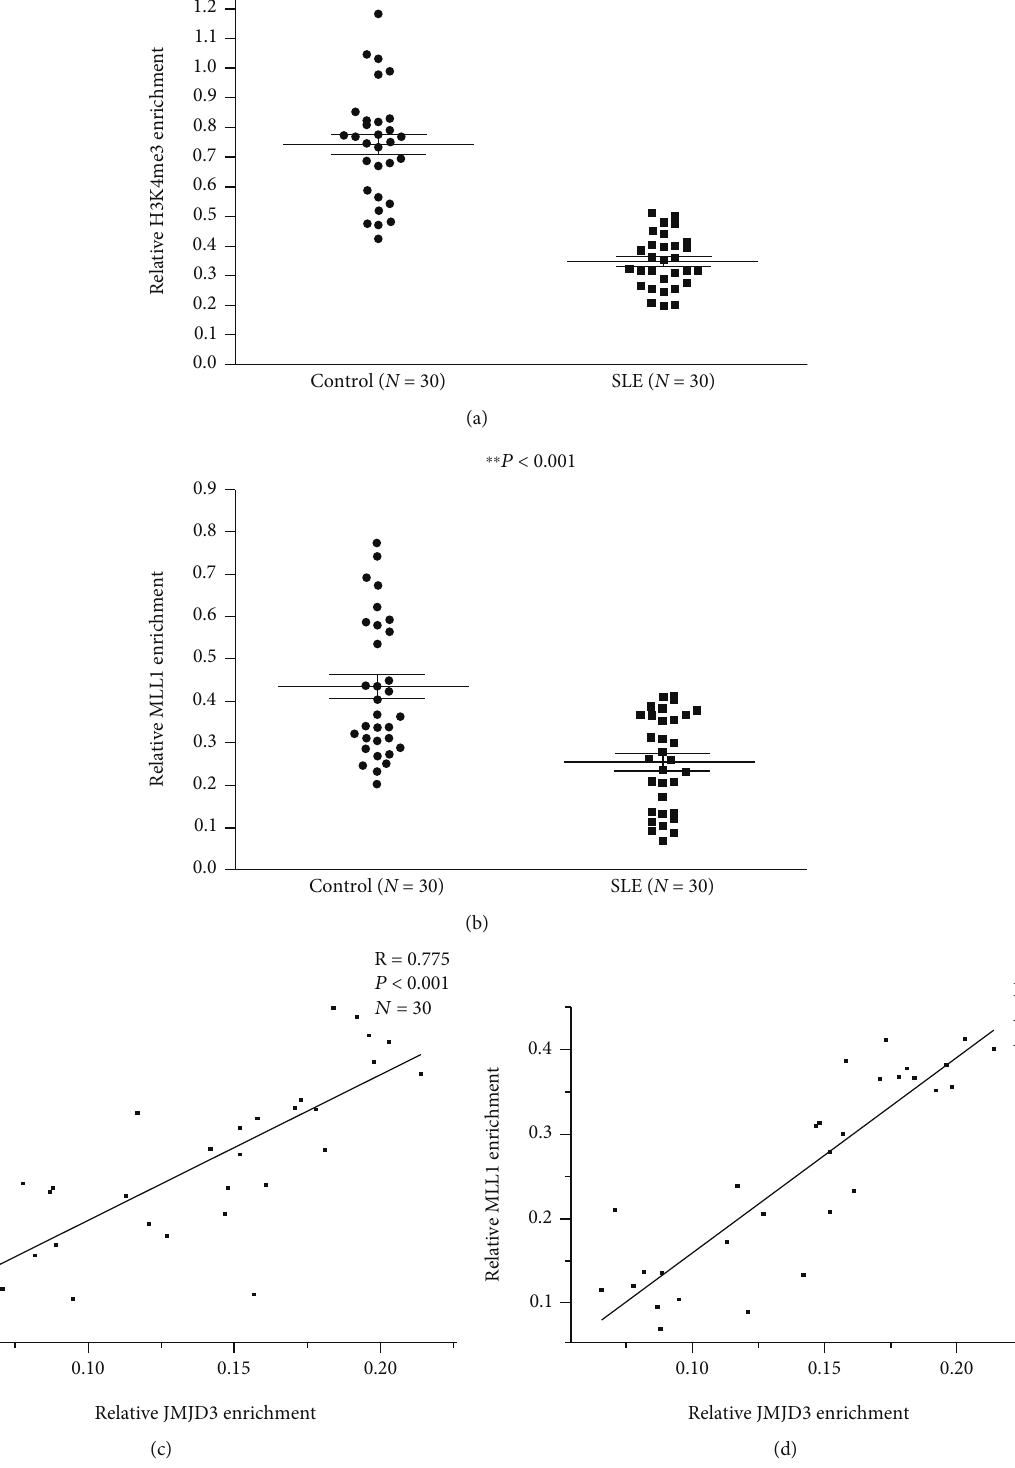
Figure 5: H3K4me3 and MLL1 enrichments at the HPK1 promoter in healthy and SLE Tfh cells. (a, b) Relative H3K4me3 (a) and MLL1 (b) enrichments at the HPK1 promoter in healthy and SLE Tfh cells were measured by combining ChIP and qPCR assays. Results were normalized to input DNA (total chromatin). (c, d) The correlations between H3K4me3 enrichment (c), MLL1 enrichment (d), and JMJD3 binding in SLE Tfh